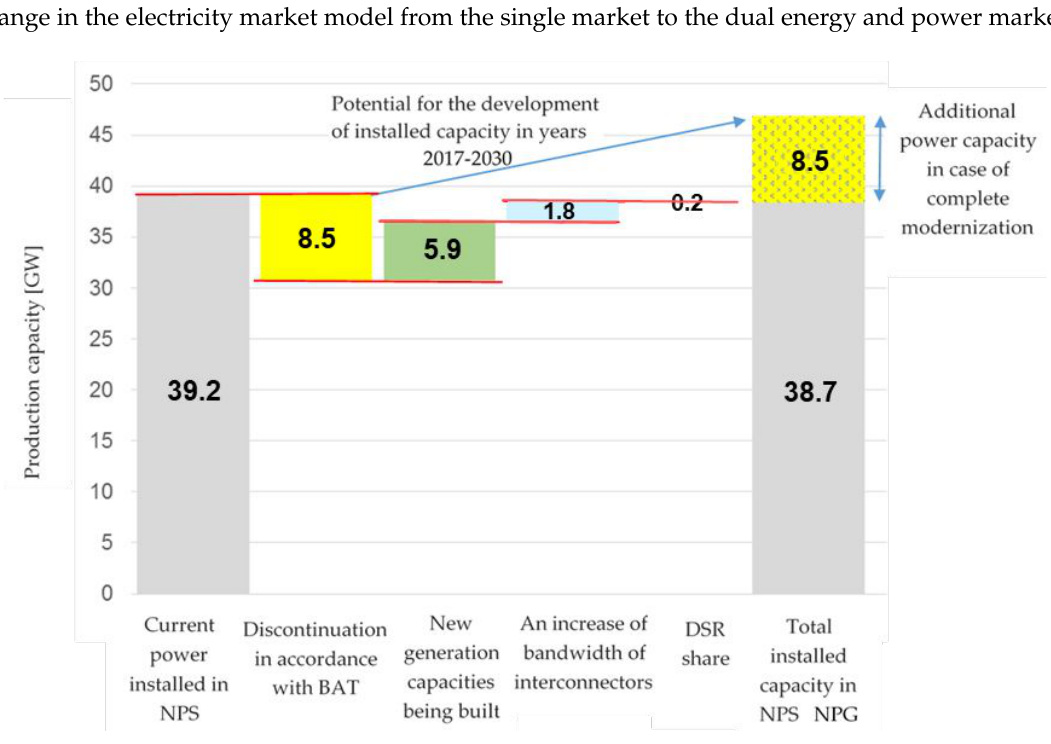
Figure 1. The perspective of changing the volume of installed capacity in the NES in the years 2020–2030 according to the Best Available Techniques (BAT)